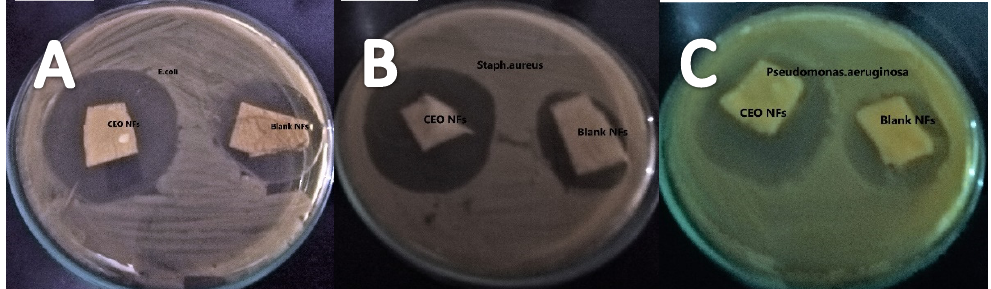
Figure 7 . Zone of inhibition of CEO NFs and blank NFs observed against Escherichia coli ( A ), Staphylococcus aureus ( B ), and Pseudomonas aeruginosa ( C ).